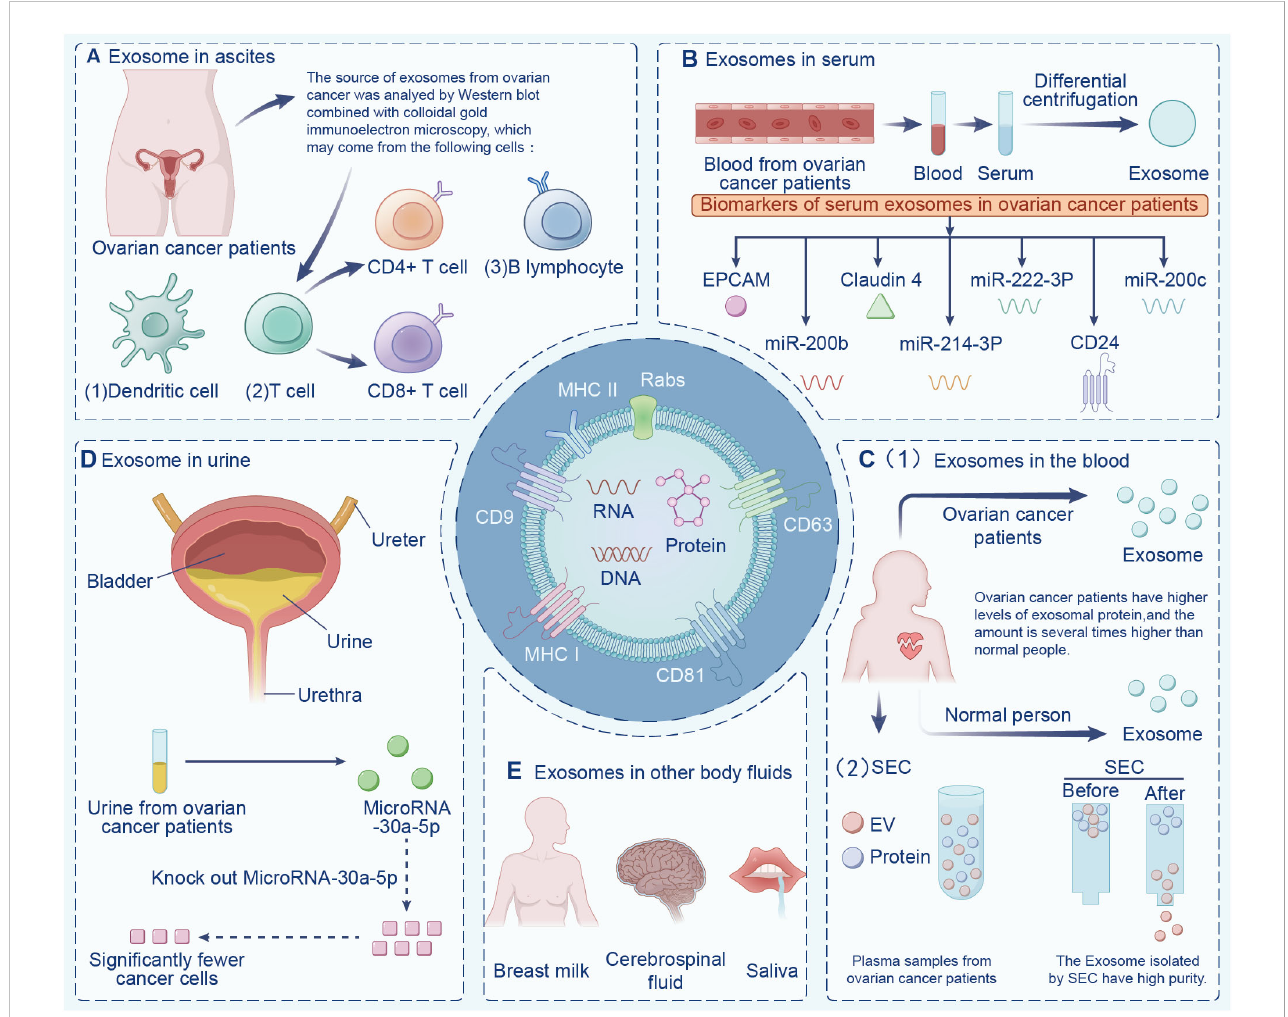
FIGURE 2 Exosomes in different body fl uids. Exosomes are widely found in a variety of body fl uids, including (A) ascites, (B) serum, (C) blood, (D) urine, and (E) in other fl uids have the potential to be immune markers due to their